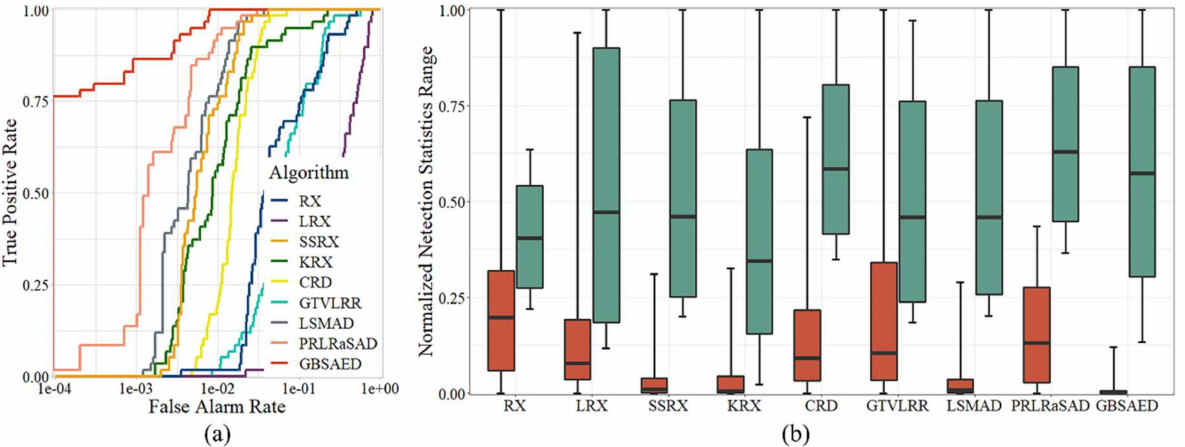
Figure 12. Quantitative analysis of the detection results of the various algorithms for the San Diego Image: ( a ) ROC curves and ( b ) target-background separation map.